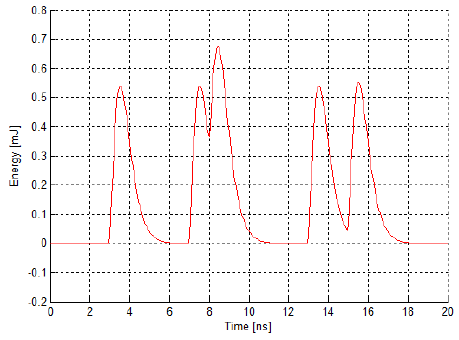
Figure 12. Waveform generated by summation without noise